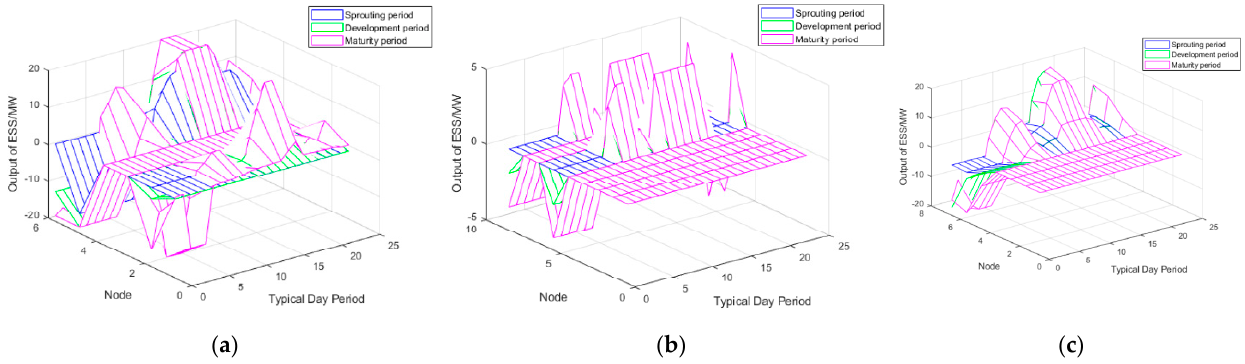
Figure 4. Output of ESS unit at each typical stage of the system: ( a ) transmission network; ( b ) distribution network 1; ( c ) distribution network 2.